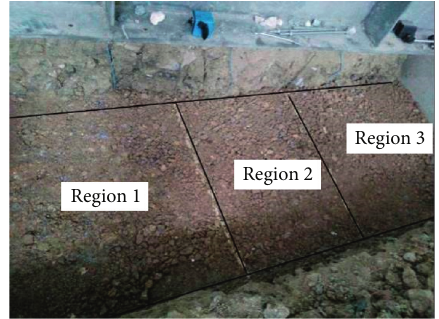
Figure 8: The division of the test area.